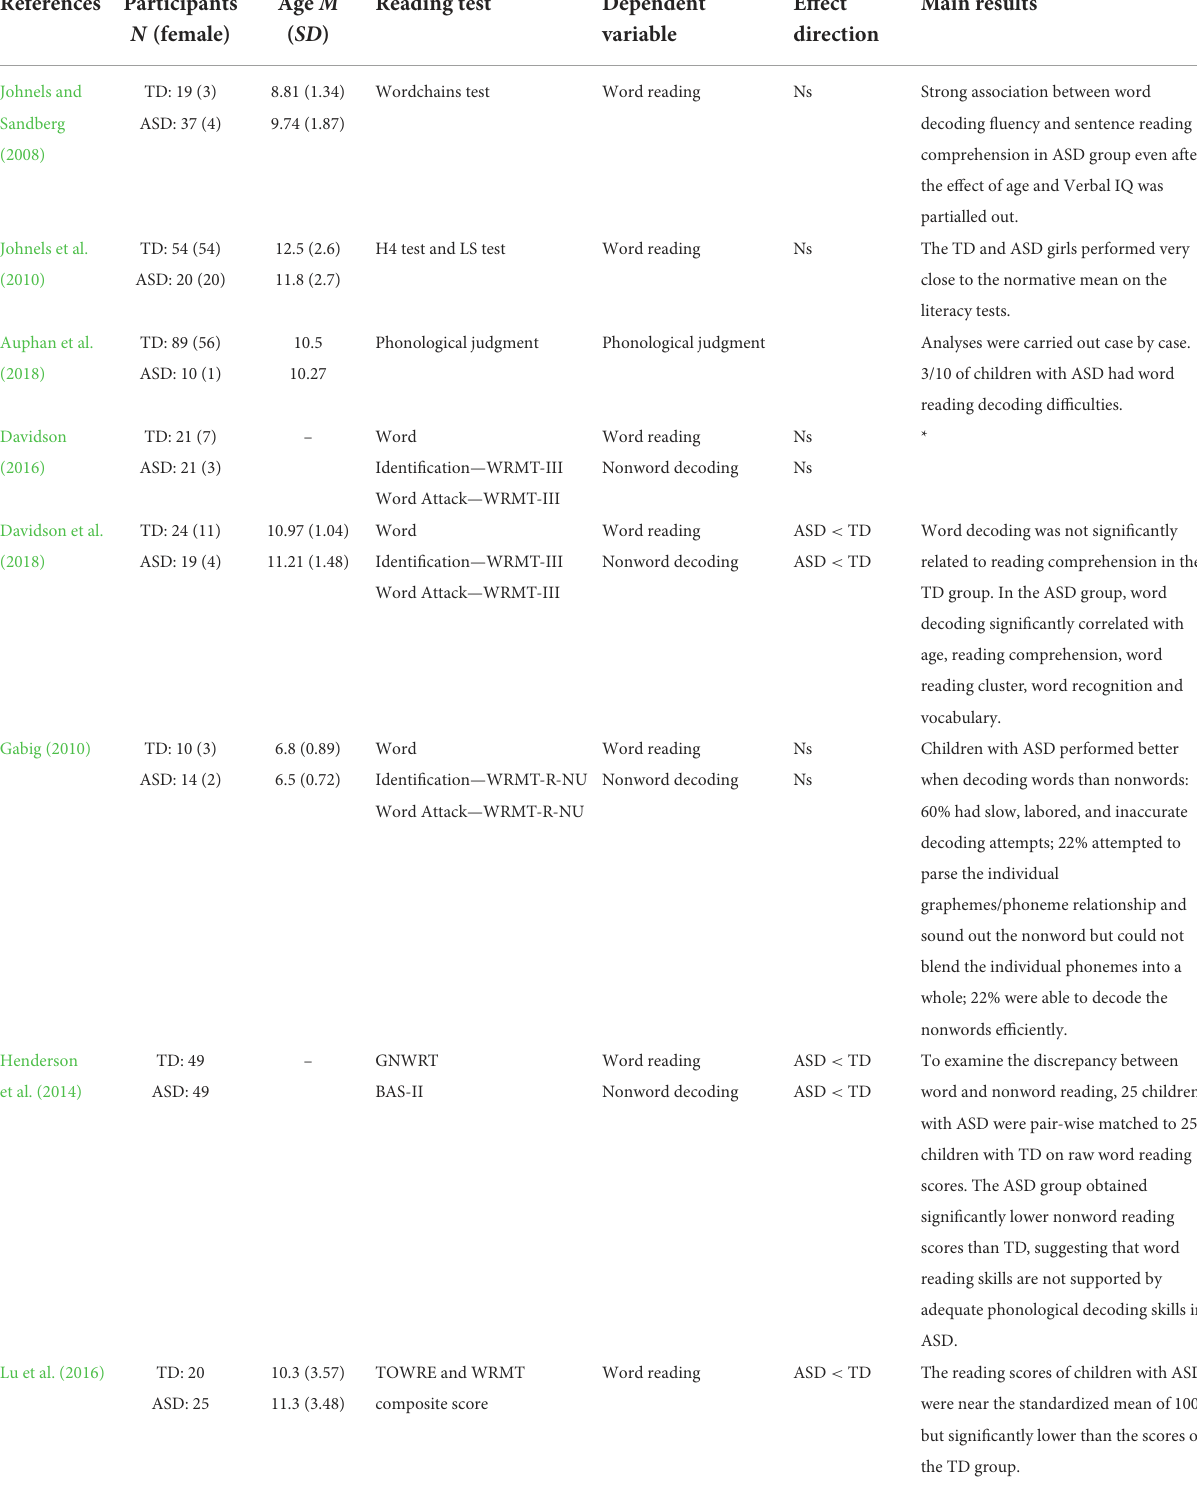
TABLE 2 Results of the studies that compared the performance of children with ASD with children with typical